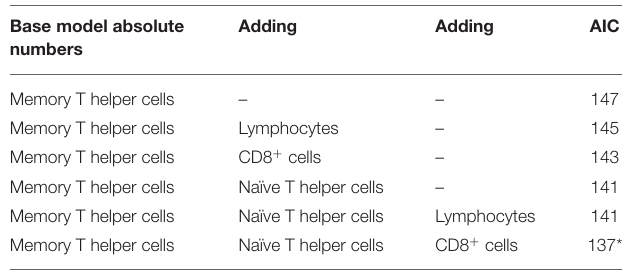
TABLE 4 | Significant explanatory variables for histology score as response variable with no interaction with housing.